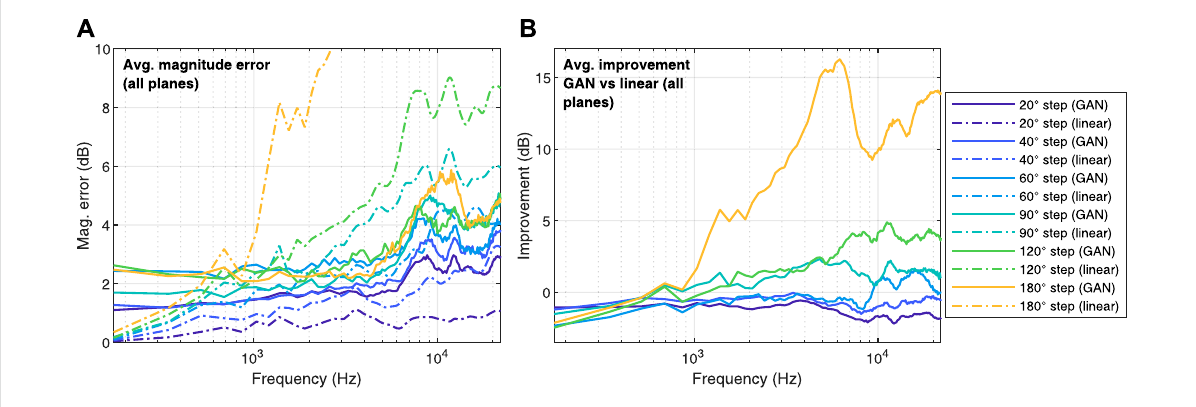
FIGURE 2 (A) :magnitudeerror, averagedoverbothearsand overall availabledirections. (B) :improvement oftheGANcompared withlinear interpolation (values greater than zero indicate that the GAN obtained a lower magnitude error than linear interpolation). Data of all three planes were pooled